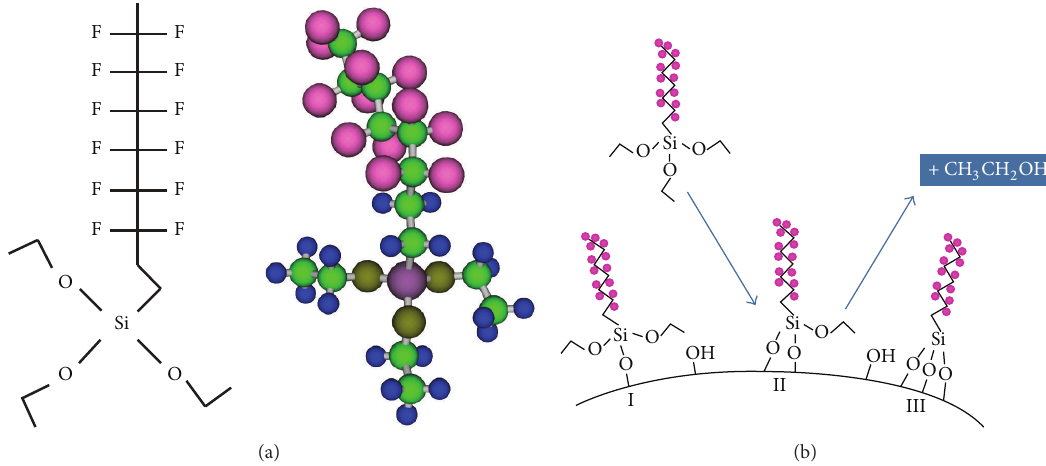
Figure 2: (a) The structure of F-TEOS. (b) Possible reaction mechanisms of the surface modifier, F-TEOS, with hydroxyl groups on silica. Three possible attachments of F-TEOS to the silica surface are possible. Mechanisms I and II leave ethoxysilane groups on F-TEOS that might react with neighboring tethered or free F-TEOS groups resulting in multilayered coverage on the silica nanoparticle.